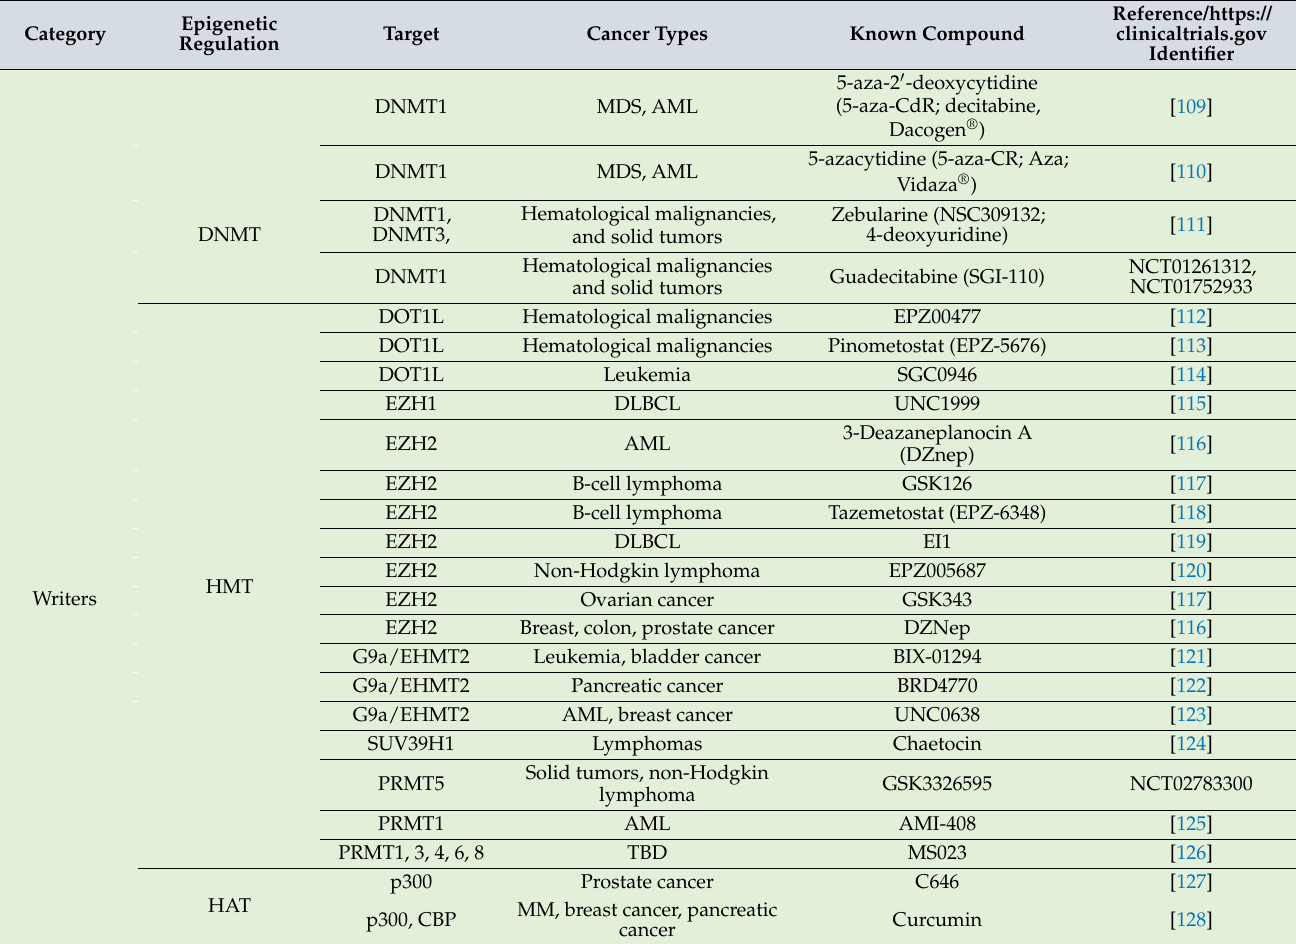
Table 2. Epigenetic inhibitors in different cancer types (Adapted from